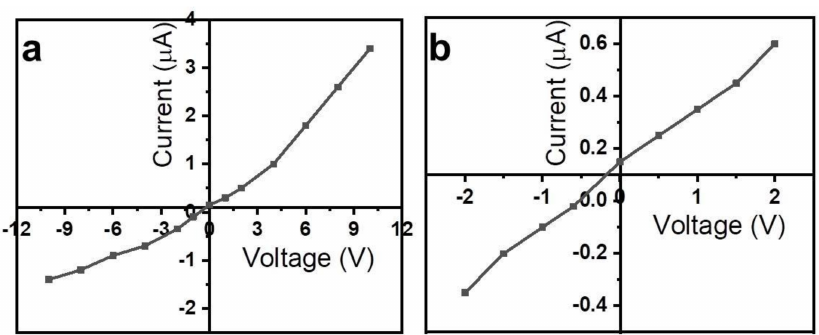
Figure 3. Volt-ampere characteristics of the rubber-based Al/OD-Gel/Cu electrochemical cells in the wide range of applied voltages ( a ) and narrow range of applied voltage ( b